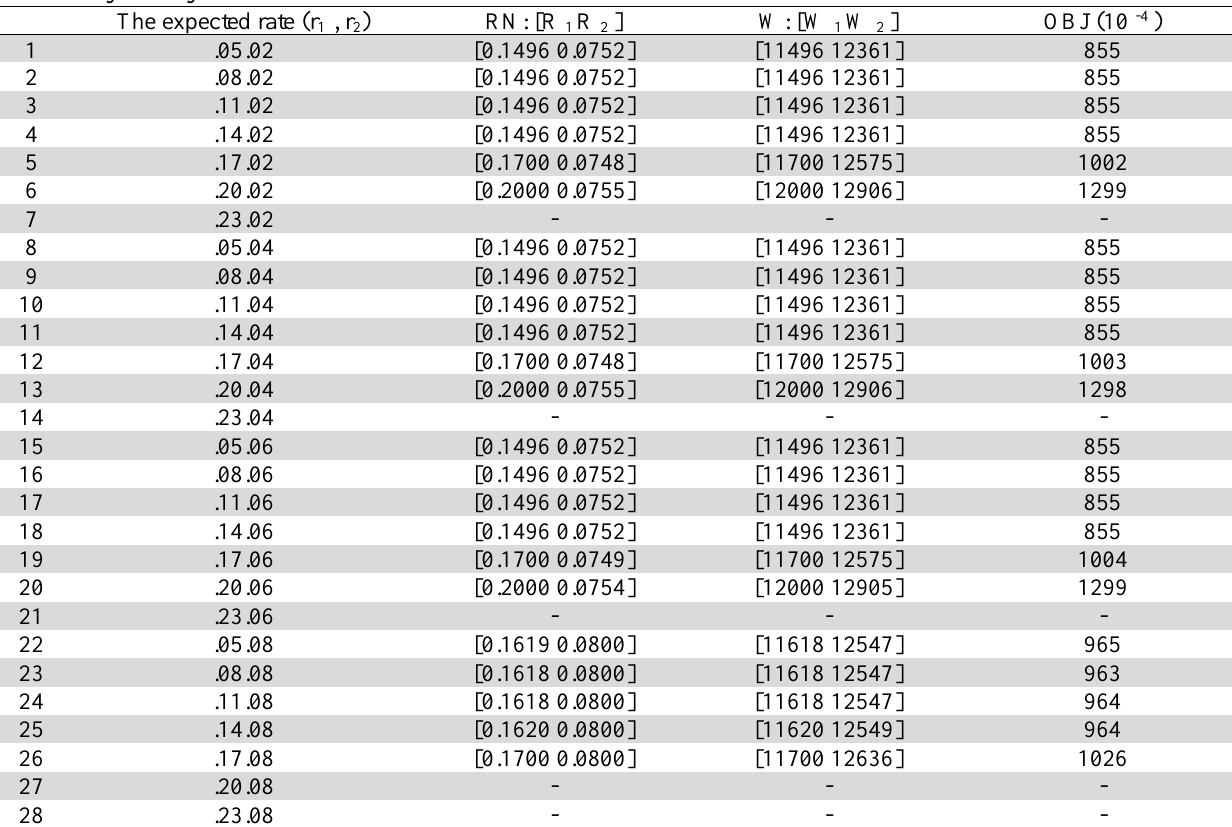
Sensitivity Analysis Parameters and